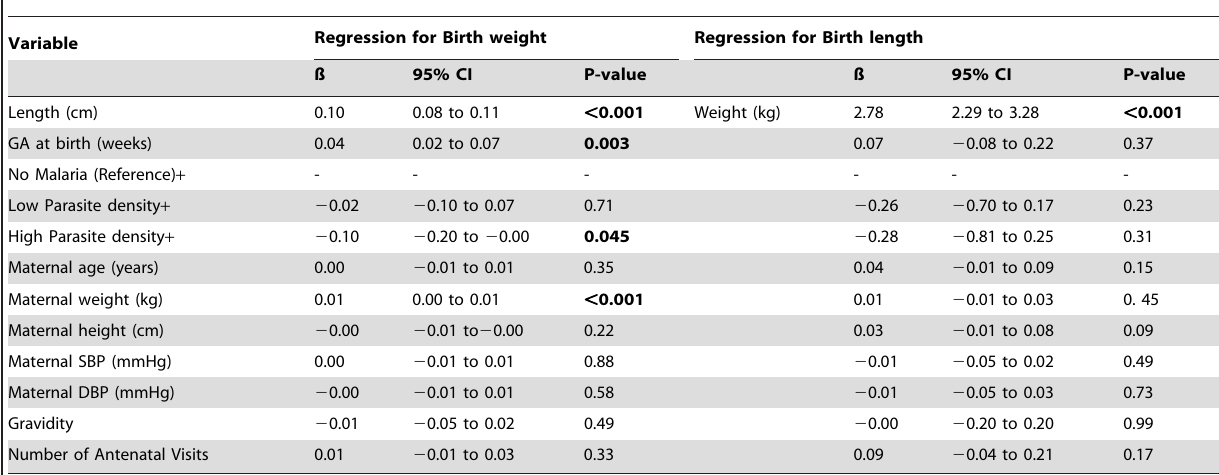
Table 5. Multiple regression analyses for determinants of birth size including maternal malaria parasite